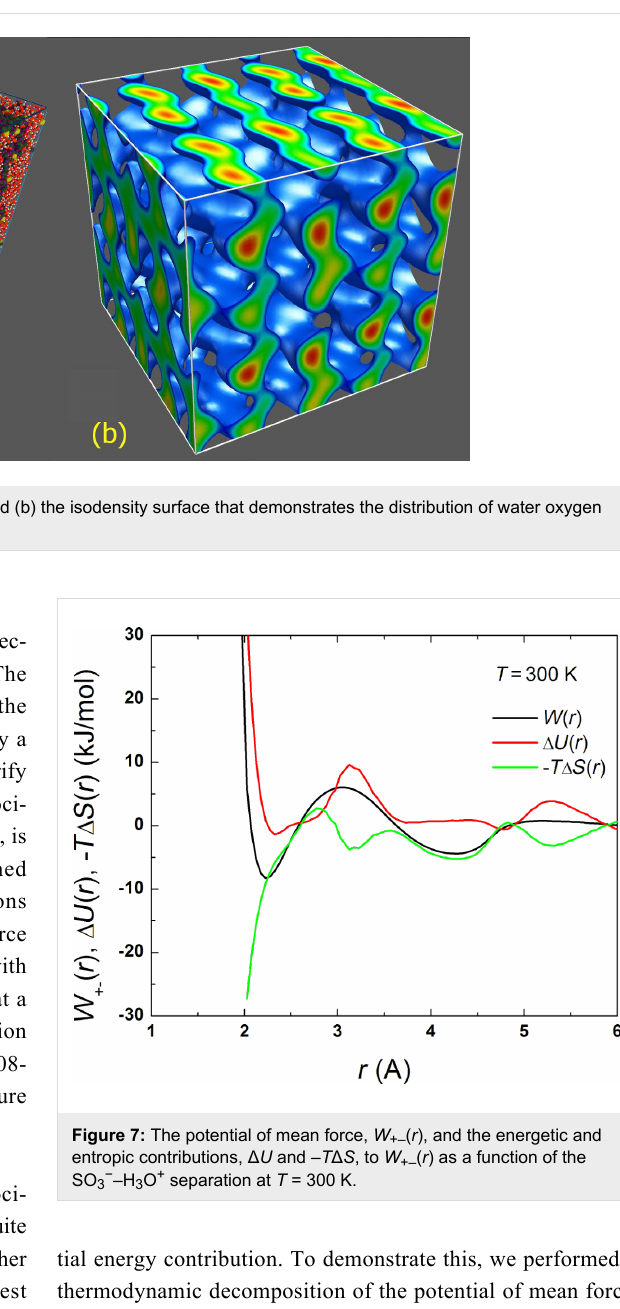
Figure 7: The potential of mean force, W +– ( r ), and the energetic and entropic contributions, Δ U and – T Δ S , to W +– ( r ) as a function of the SO 3 − –H 3 O + separation at T = 300